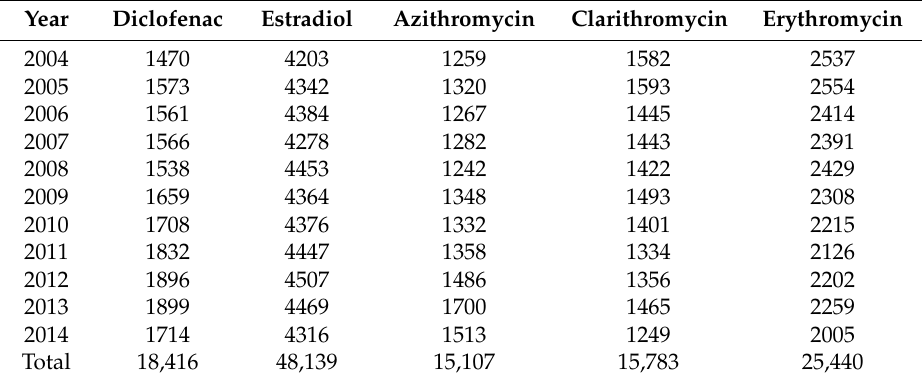
Table 5. Total Scopus Number of Documents with the terms Diclofenac, Estradiol, Azithromycin, Clarithromycin, and Erythromycin from 2004 to 2014.